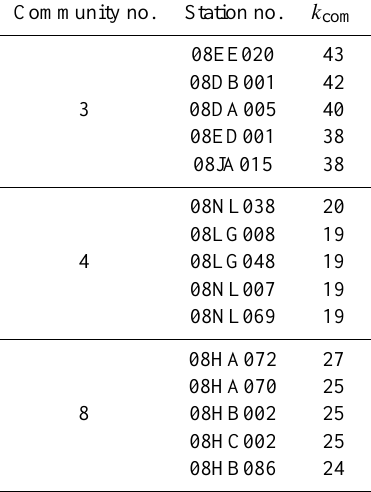
Table 3. The most highly connected (in an intracommunity sense) stations in each of the three largest communities and the number of intracommunity links ( k com ). These stations could serve as index stations for their respective community. Community no. Station